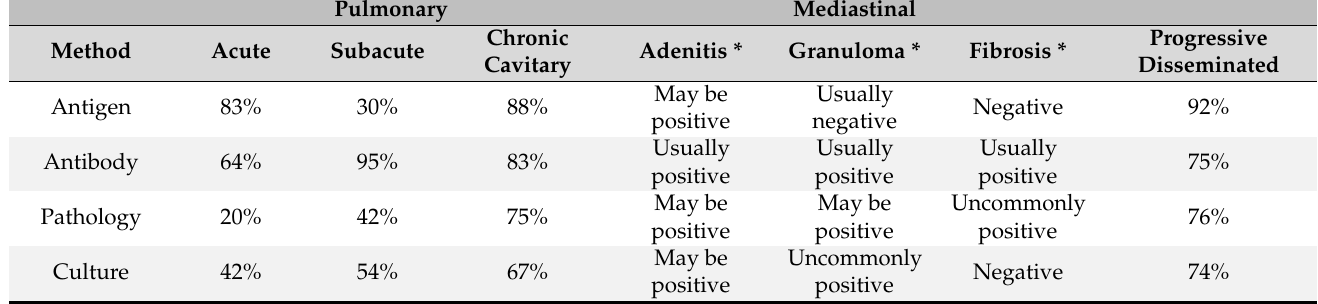
Table 1. Sensitivity of diagnostic tests in different clinical forms. * Mediastinal forms do not have well established sensitivity for the different testing strategies. Table adapted from Hage Ca, et al. [25].